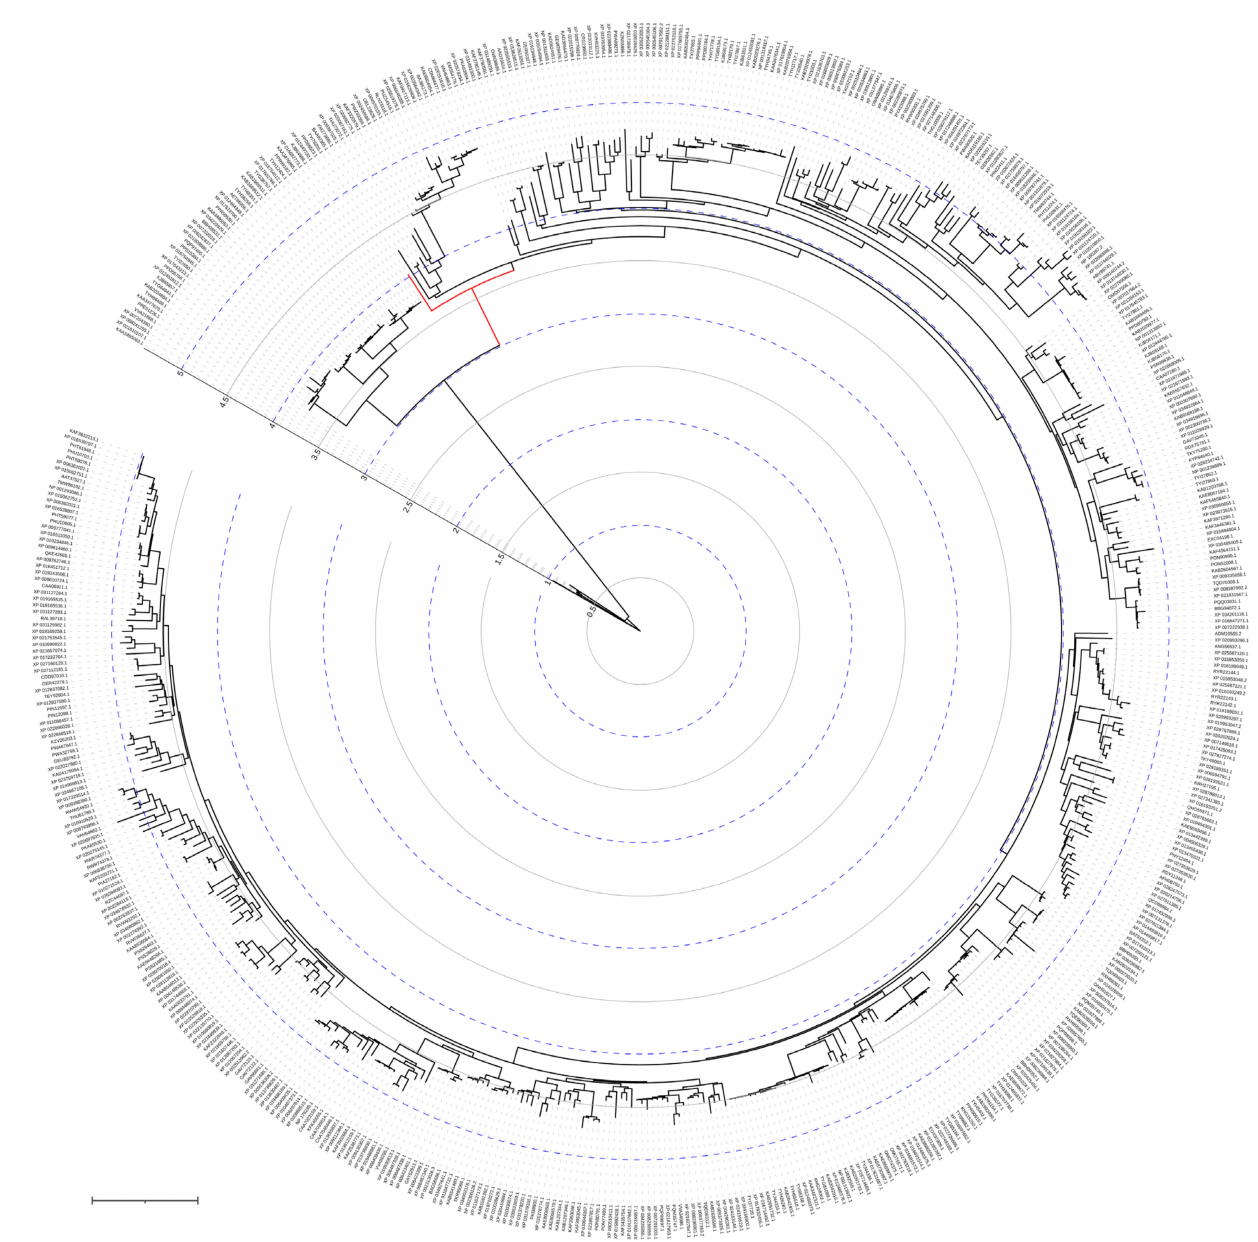
Figure 14. Phylogenetic tree of ACP and its homologous enzymes (down to 40% identity). The tree was built as previously with UniProt Q9MB07 as a reference sequence. Enzymes having high (90–100%) identity are highlighted with